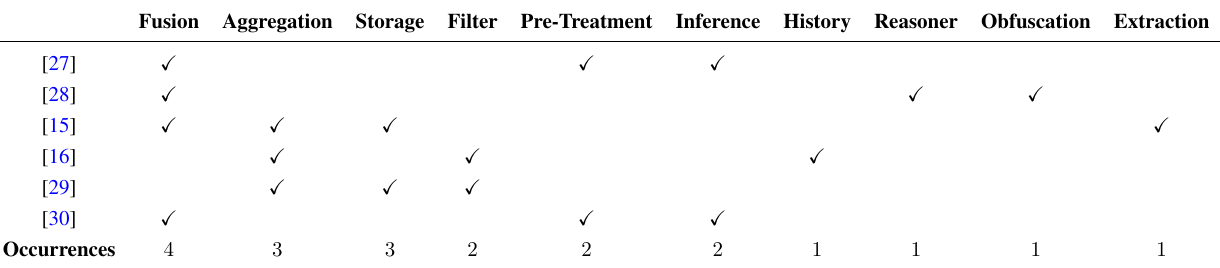
Table 3. Context processing